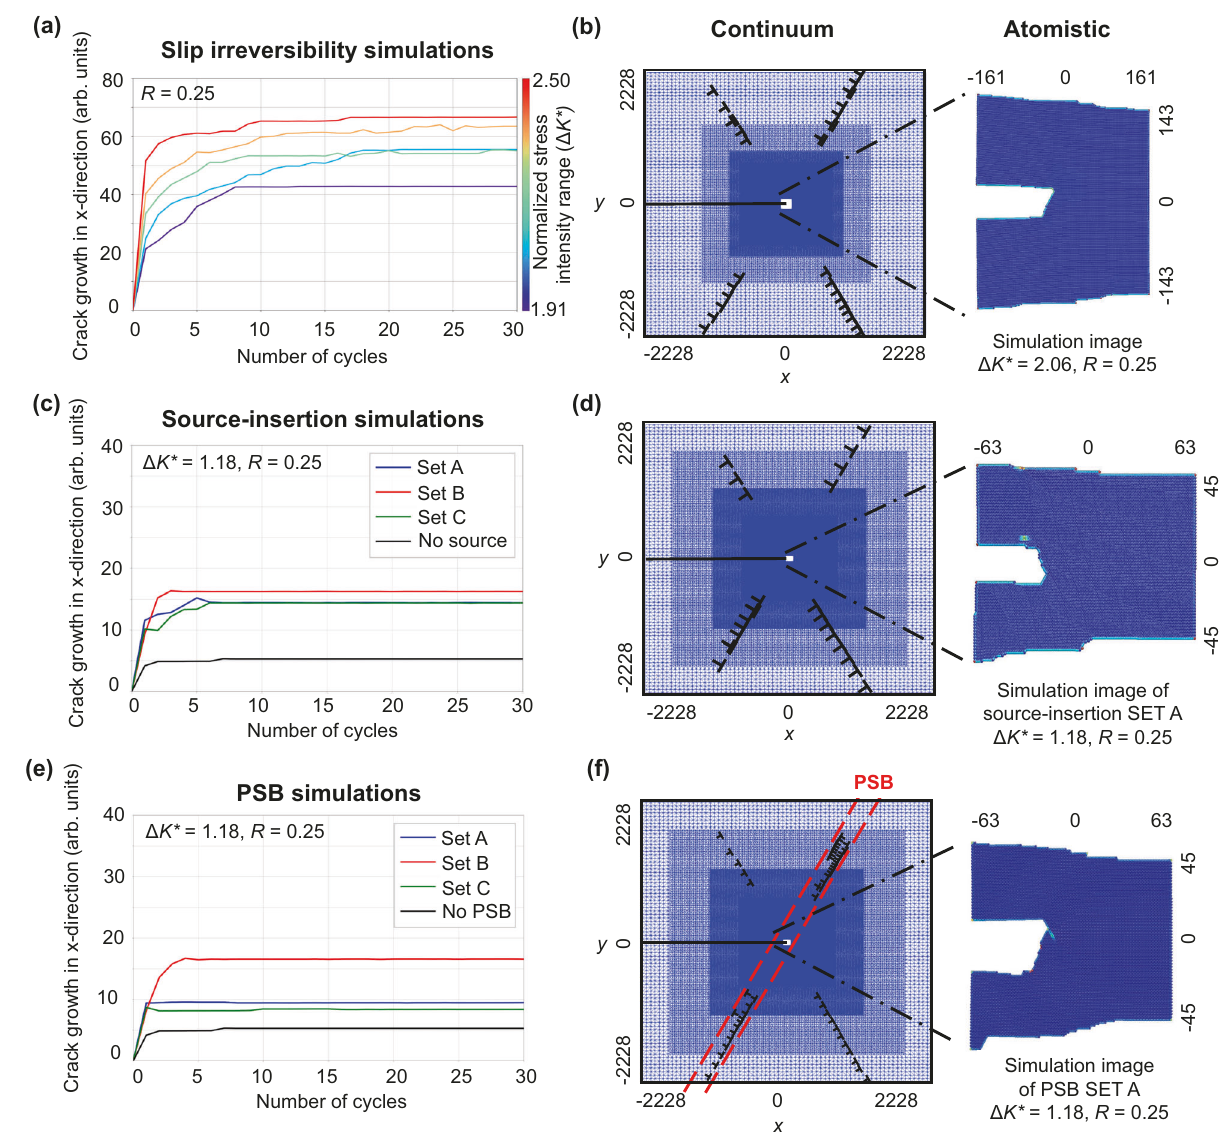
Fig. 2 Crack advance as a function of loading cycle from three sets of simulations. Sample continuum and atomistic con fi gurations are shown from when the crack reaches an arrested state. a and b Simulations with slip irreversibility, where dislocation motion is limited to the direction away from the crack tip. c and d Simulations with dislocation sources in the continuum, which exhibit enhanced crack growth over the initial cycles, but eventually crack arrest. e and f Simulations with pre-existing dislocations in the continuum aligned as a persistent slip band (PSB) in red dashed line. The presence of the PSB dislocations enhances growth over the initial cycles, but eventually crack arrest occurs. Details about SET A, B, and C in ( b ) and ( c ) are discussed in the “ Methods ” section. Distances are normalized by the magnitude of the Burgers vector, b , and the range of the normalized stress intensity factor that is used to characterize the loading amplitude, Δ K (cid:1) ¼ Δ K I = K nuc I